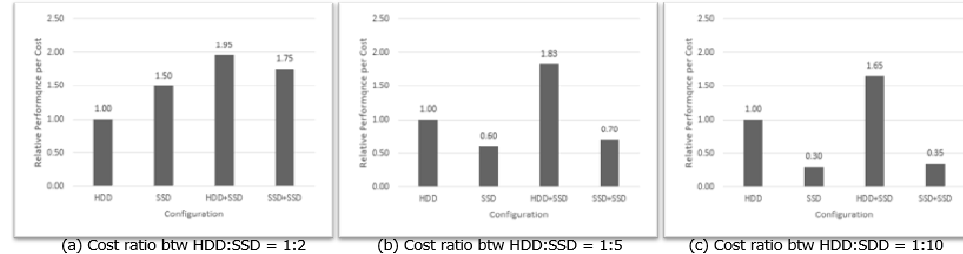
Figure 13. Performance over cost ratio: the normal/urgent separation is a cost-effect